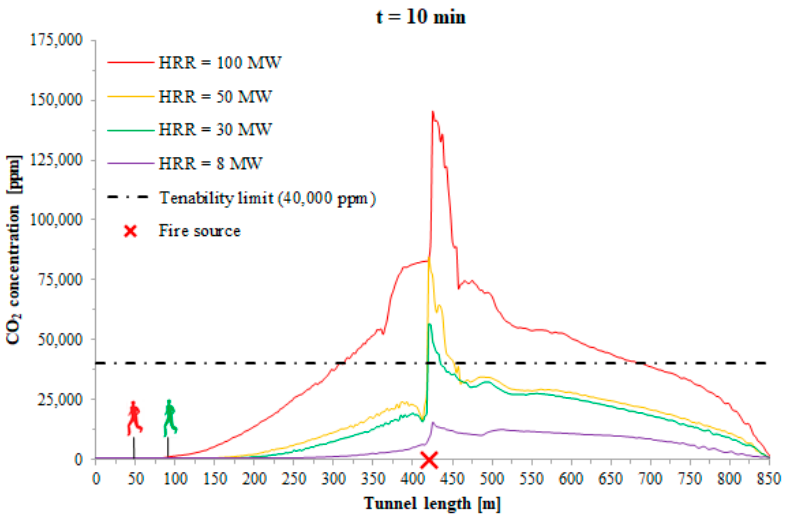
Figure 6. Longitudinal CO 2 concentration profiles (t = 10 min) at a height of 2 m along the escape path when the fire source is in the middle of tunnel length.